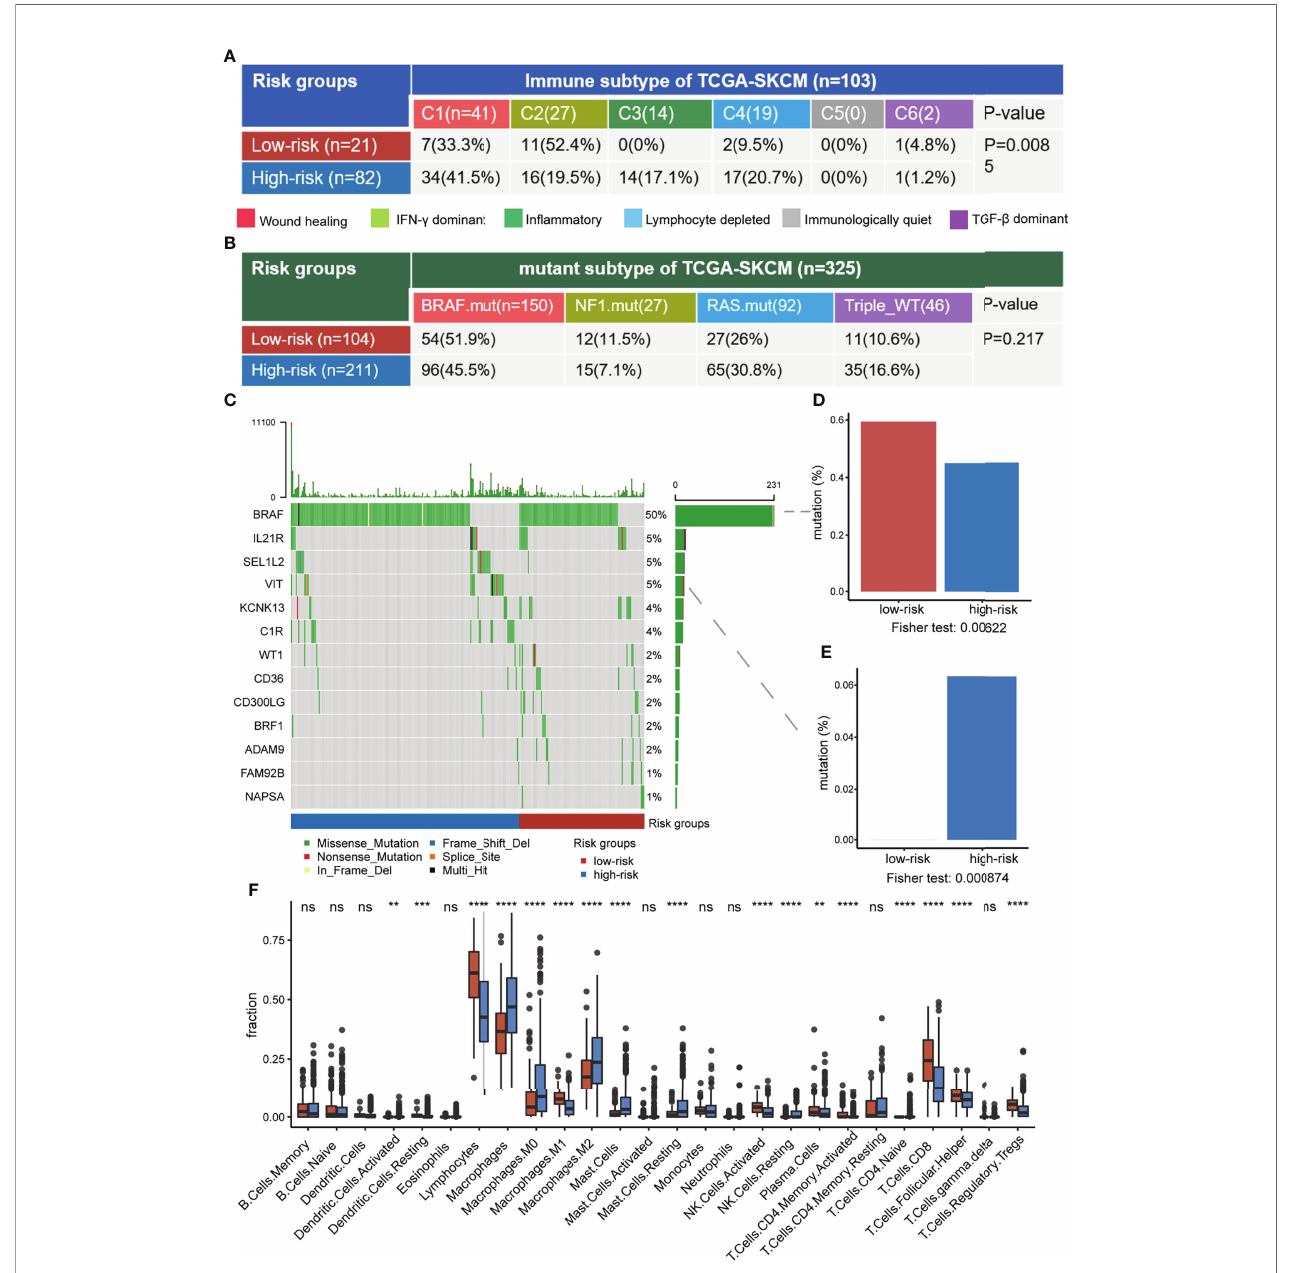
FIGURE 8 | Comprehensive characterization of risk groups. (A, B) The association between risk groups with immune subtypes (A) and TCGA mutant subtypes (B) in the TCGA-SKCM cohort. (C) The oncoplot of selected genes with signi fi cantly different mutation fractions between risk groups. (D, E) The difference in mutation fraction of BRAF (D) and VIT (E) between risk groups. (F) The difference in immune in fi ltration between risk groups. ns, non-signi fi cant, * denoted p <0.05, ** denoted p <0.01, *** denoted p <0.001, and **** denoted p